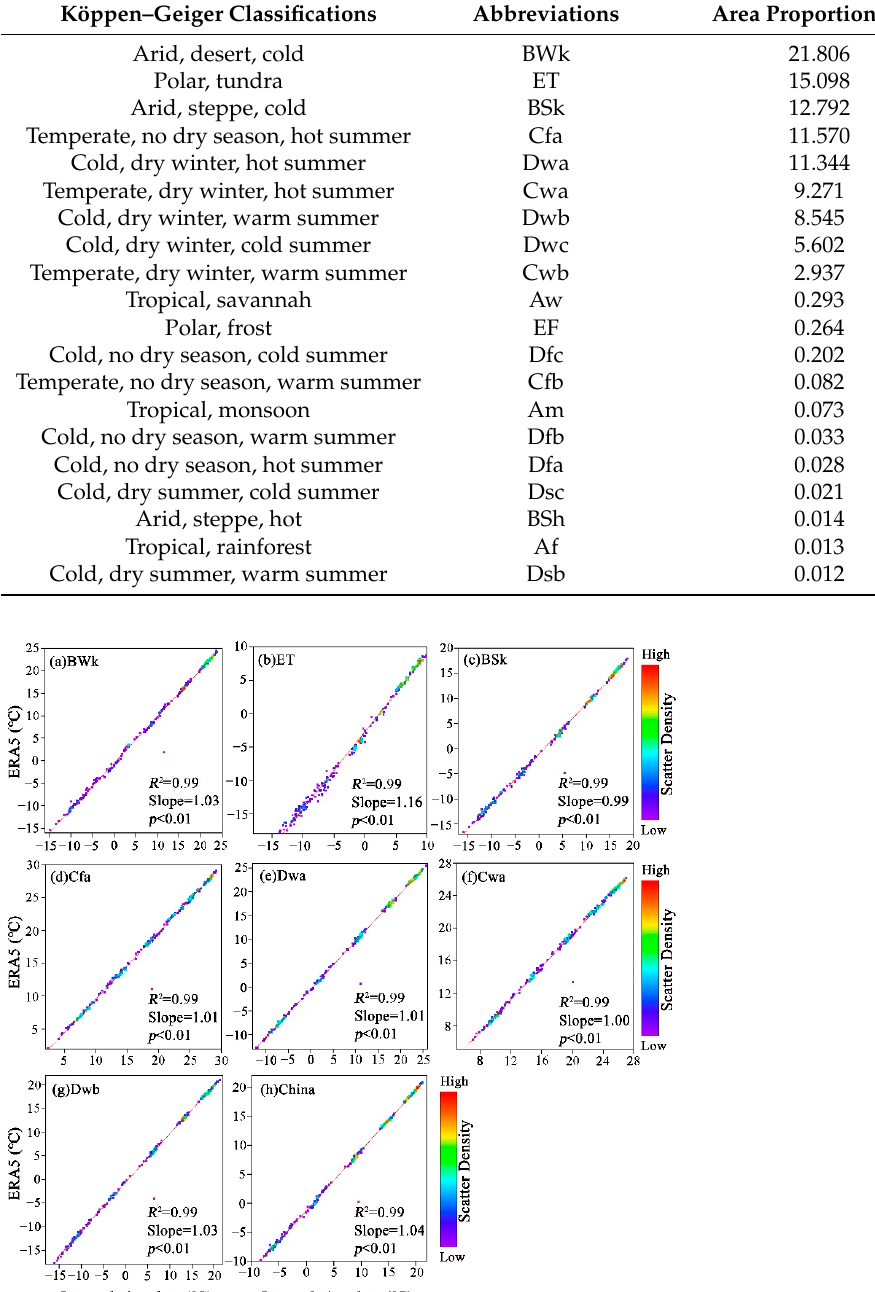
Table 3. Köppen–Geiger classifications and their area proportions of China (classifications with area proportions greater than 8% were selected for further analysis).